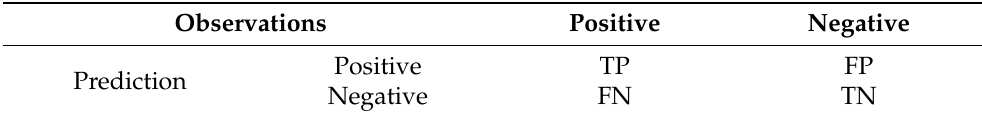
Table 1. Joint table of early warning results and observation results.